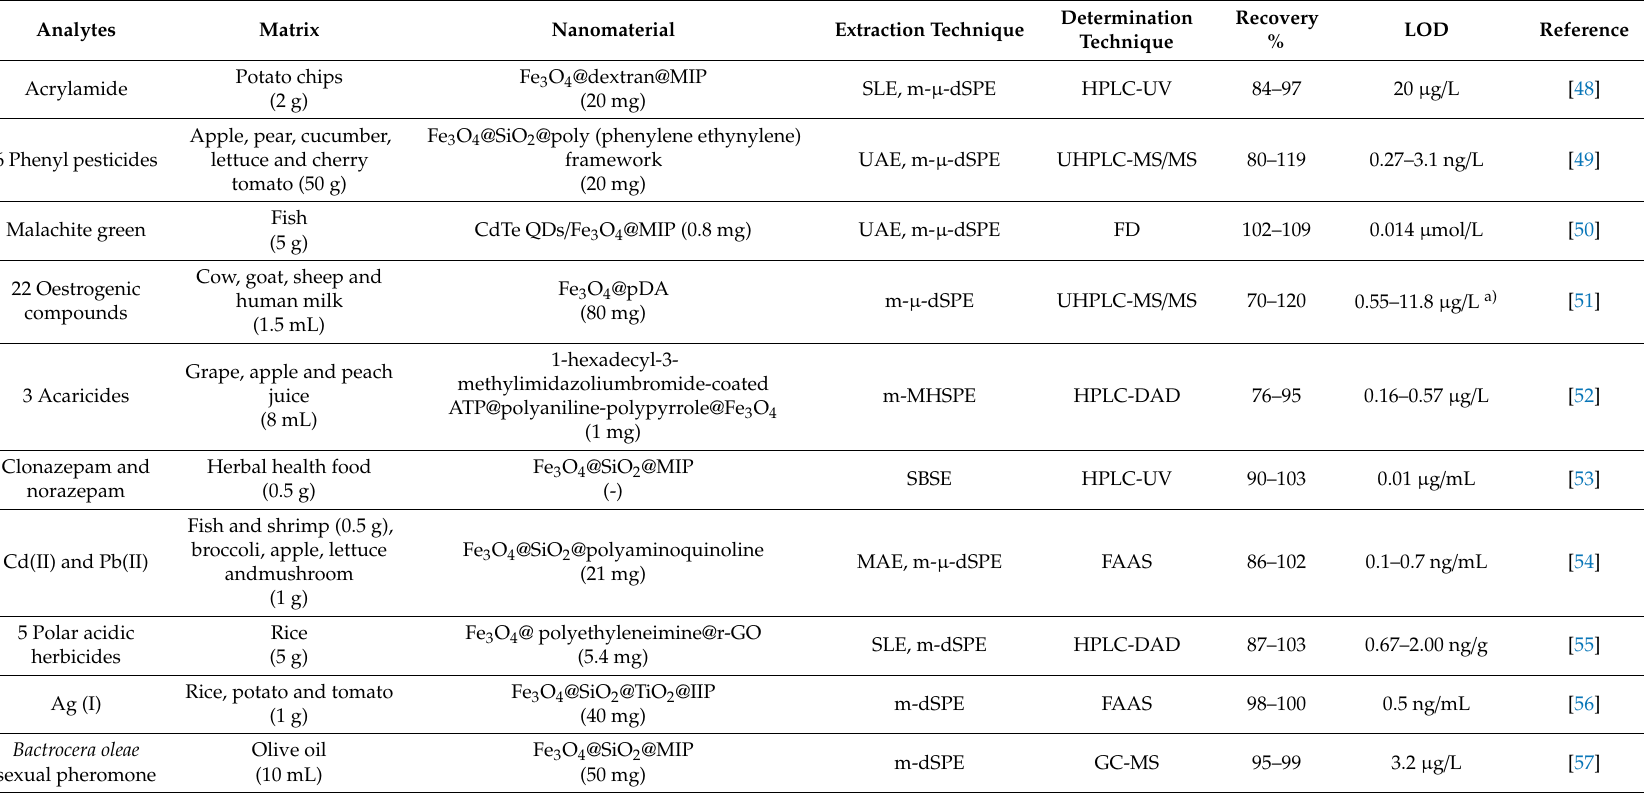
Table 3. Recent applications of magnetic polymeric nanomaterials as sorbents in food